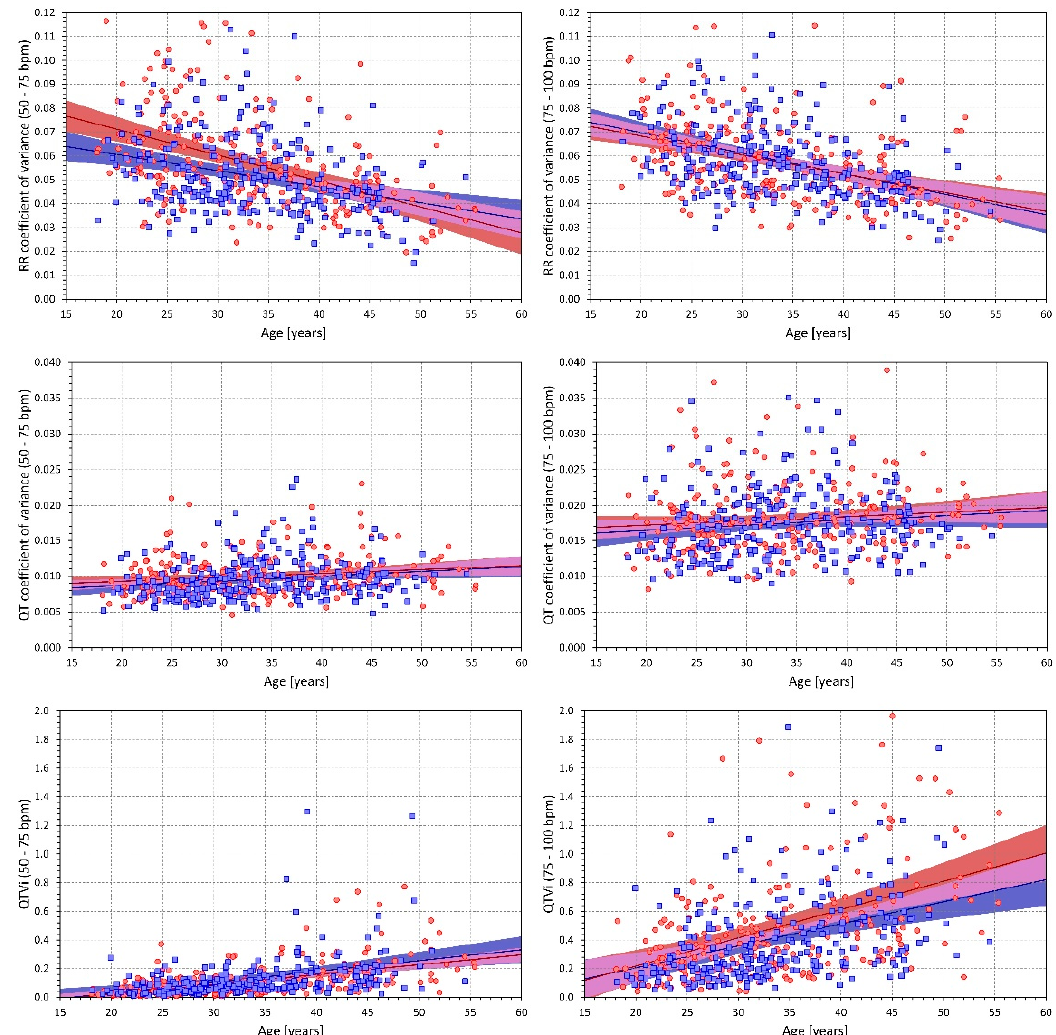
Figure 2. Relationship to age. Scatter diagrams of the relationship between age of the study subjects (horizontal axes) and RR interval coefficient of variance (top panels), QT coefficients of variance (middle panels), and QT variability index (bottom panels). The panels on the left and on the right show the relationship of age to intra-subject means calculated over ECG with heart rate between 50 and 75 bpm and between 75 and 100 bpm, respectively. In each panel, the red circles and blue squares correspond to female and male subjects, respectively. The solid red and solid blue lines show the linear regressions between the ages and the intra-subject mean values. The red shaded and blue shaded areas are the 95% confidence bands of the regression lines; the violet areas are the overlaps between the confidence bands of the sex-specific